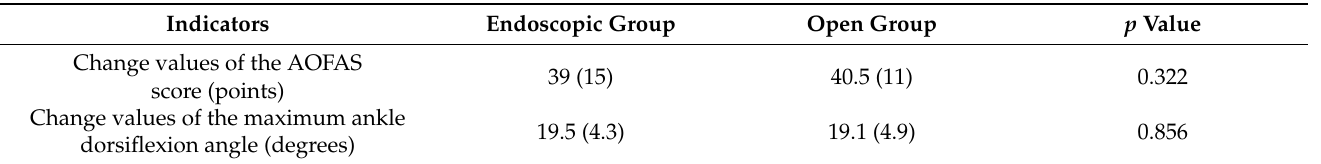
Table 4. The change values of the AOFAS score and maximum ankle dorsiflexion angle in the two